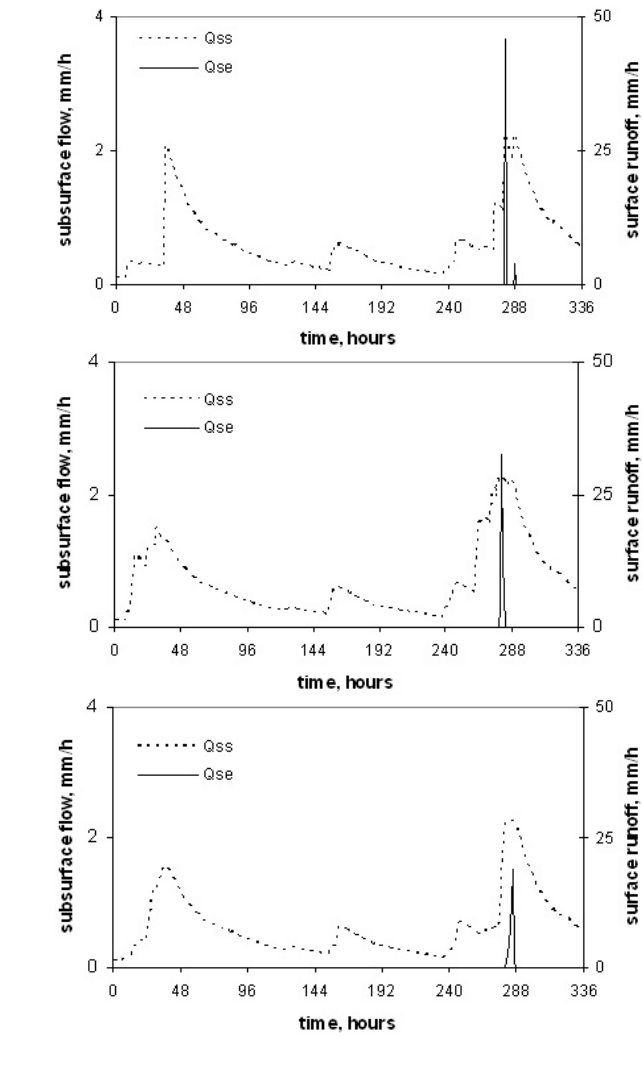
Fig. 5. The impact of bucket capacity generated by Model 4 using η =0.5 and (a) S b =100m, (b) S b =150 mm, and (c) S b =200mm.